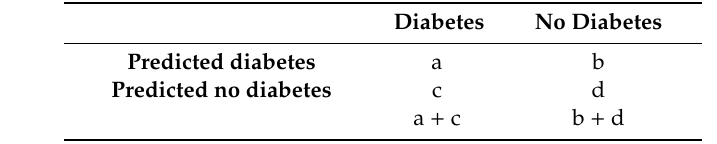
Table 9. Confusion matrix for the testing set based on di ff erent combinations of input parameters. Trial 1 Prediction